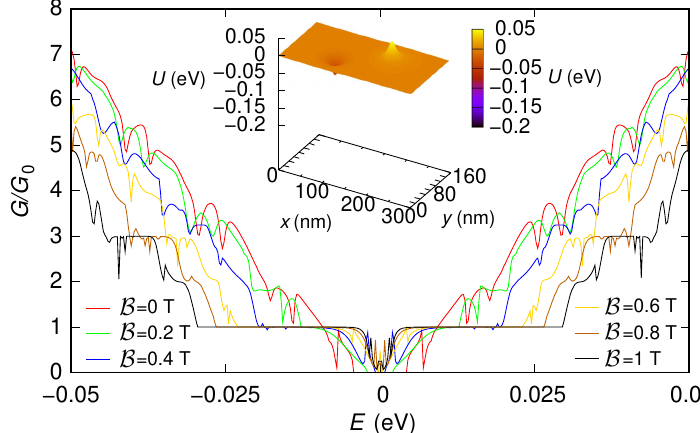
Figure 6. Conductance G , normalized with respect to the conductance quantum G 0 , which was obtained as a function of the Fermi energy E for six values of the orthogonal magnetic field B for the 150 nm-wide and 300 nm-long graphene ribbon with a potential given by the sum of two Lorentzian functions and without including the contacts. These results have been obtained using the “first gauge”. In the inset, we represent the potential profile that we have